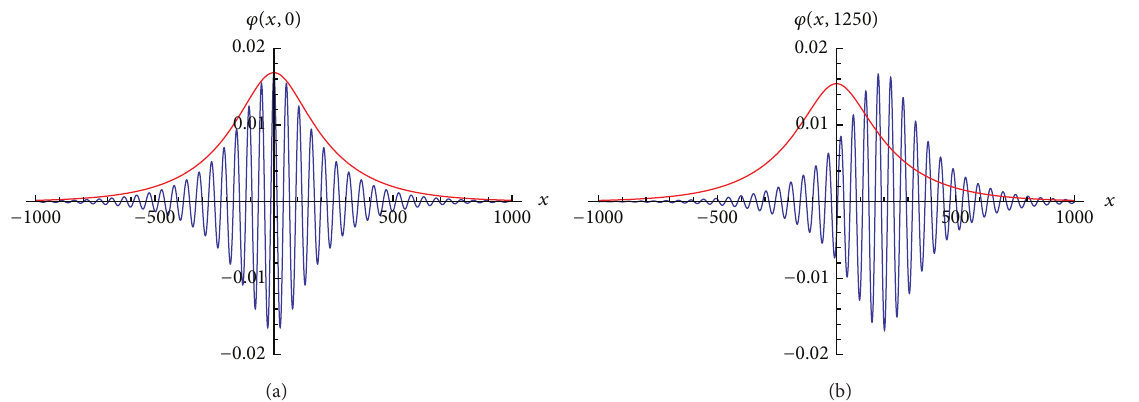
Figure 1: Profile of the usual oscillons in 1 + 1 -dimensions with Lorentz and CPT breaking for 𝑡 = 0 (left) and 𝑡 = 1250 (right) with 𝜖 = 0.01 . The thin line corresponds to the case with 𝑘 00 = 0.12 , 𝑘 11 = 0.30 , 𝑘 01 = 0.27 , and 𝑘 10 = 0.21 and the thick line to the case with 𝑘 𝜇 ] = 0